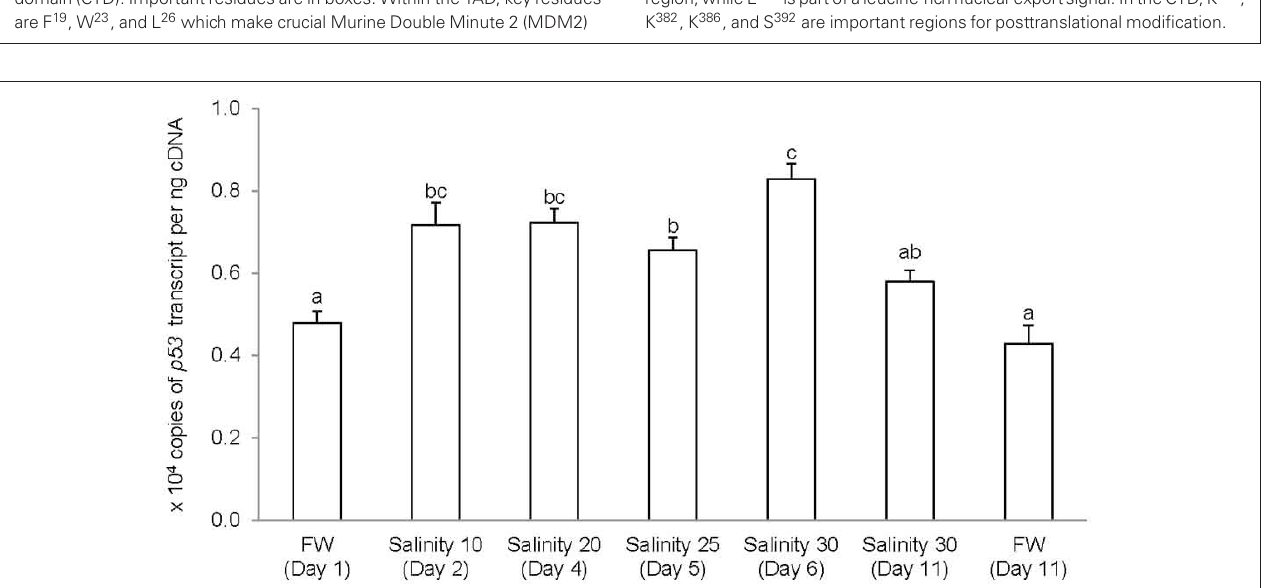
4, S 25 on day 5 and S 30 (seawater) on day 6, and then kept in seawater for another 6 days (day 11). Results are presented as means ± S.E.M ( N = 5). Means not sharing the same letter are significantly different ( P < 0 .